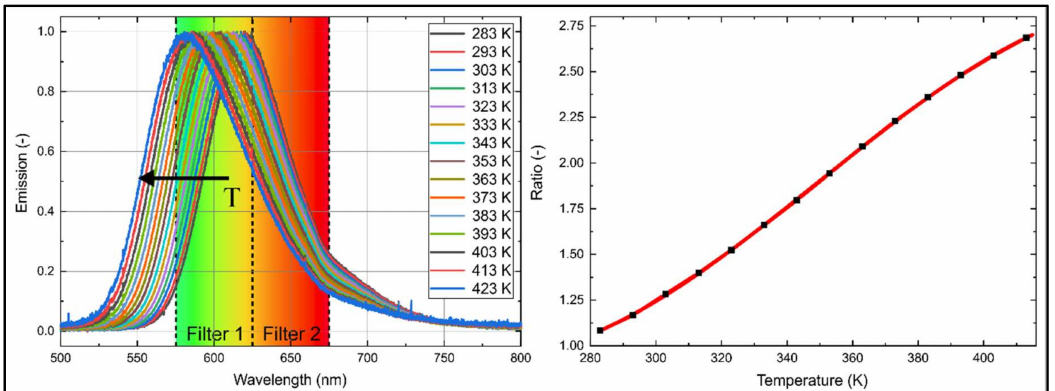
Figure 6. Temperature-dependent emission spectra of nile red (7.5 mg / L) in B20 ( left ) normalized to the maximum intensity and the intensity ratio (R 2 = 0.999) for two-color thermometry ( right ) for various